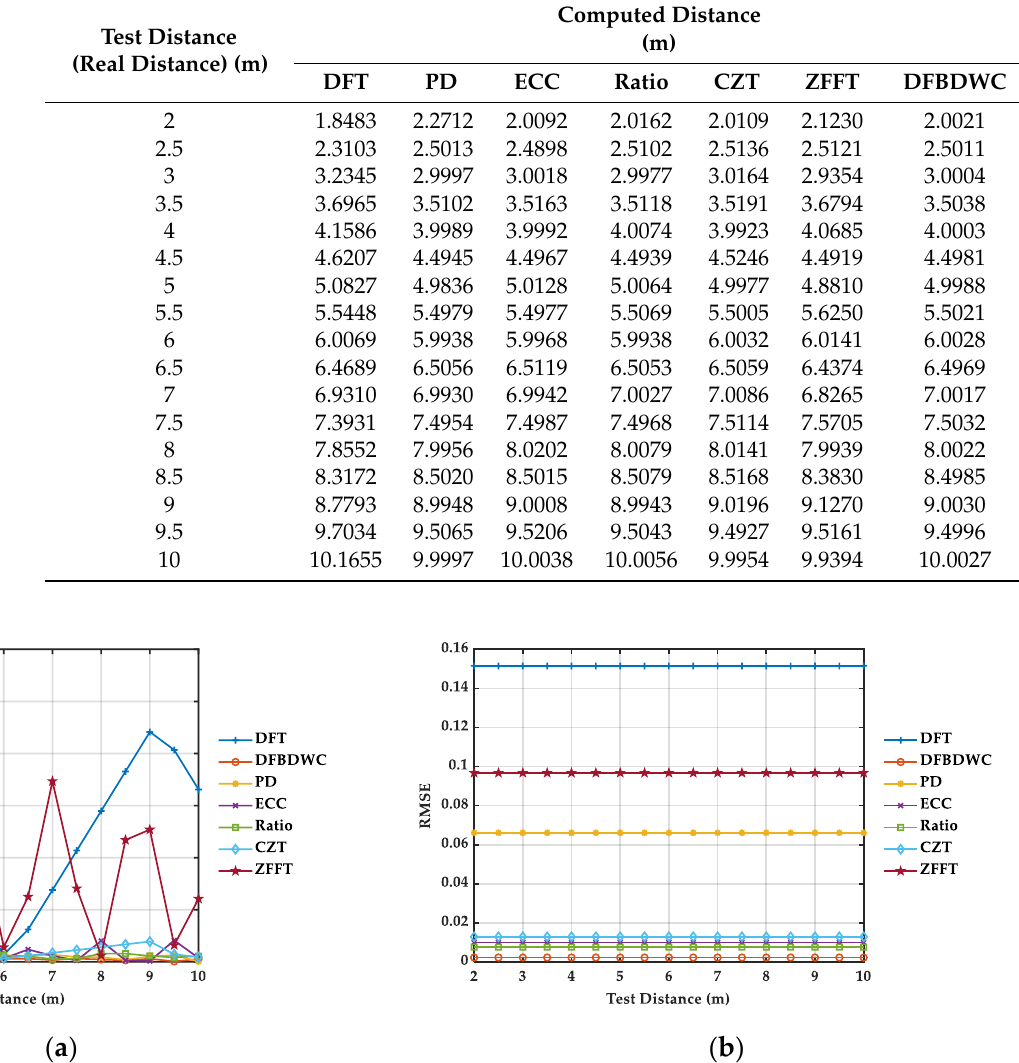
Table 4. Simulation results of AE comparison between seven algorithms. There are no WGN signals in